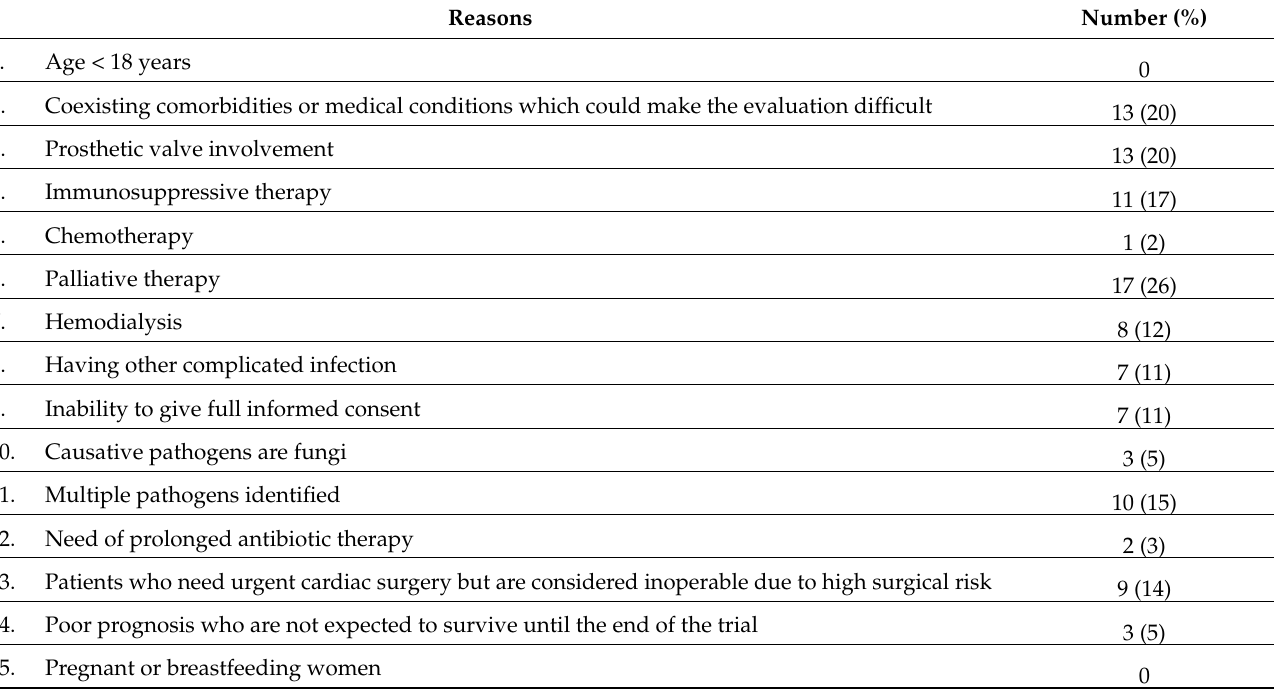
Table 2. Reasons for rejection for enrollment into a randomized clinical